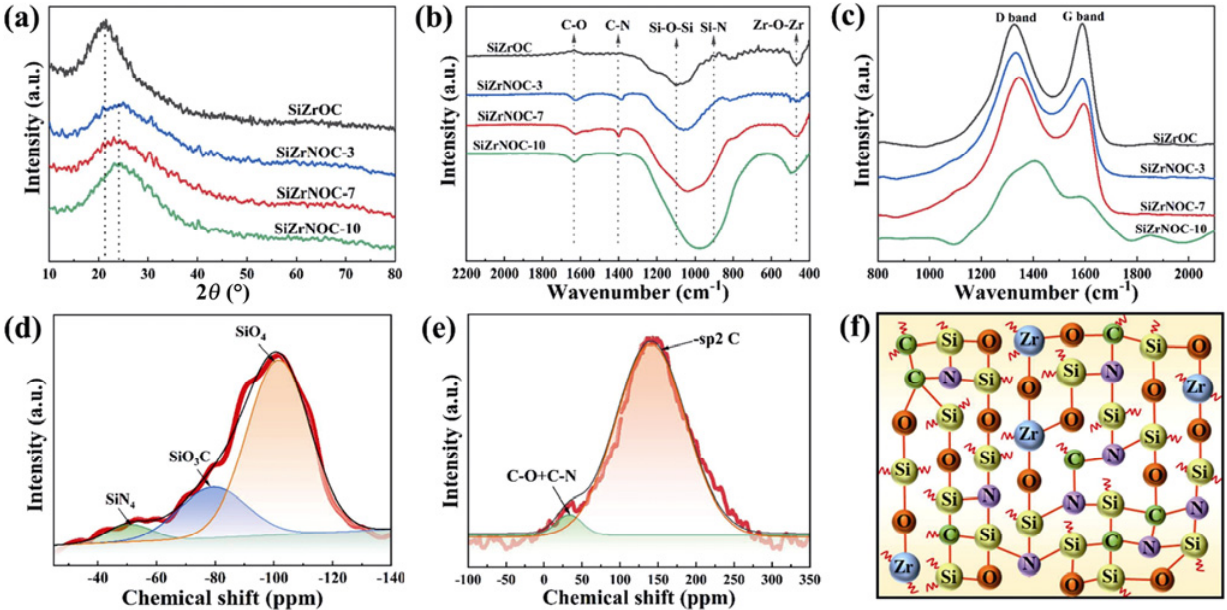
Fig. 4 (a) XRD patterns, (b) FTIR spectra, (c) Raman spectra, (d) 29 Si MAS NMR spectra, (e) 13 C MAS NMR spectra, and (f) microstructure schematic of SiZrNOC